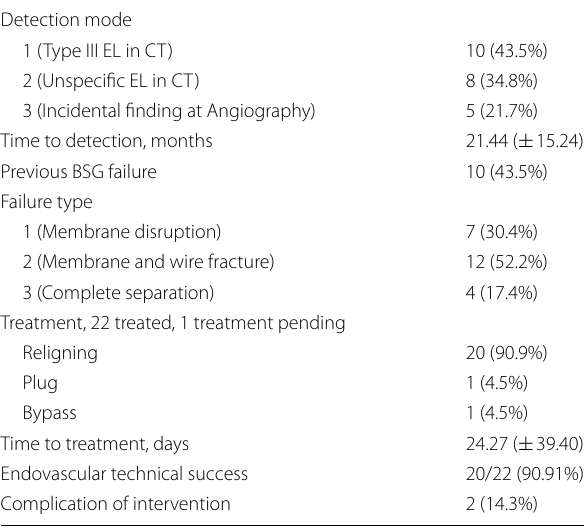
Table 3 Detection and treatment details of all failed